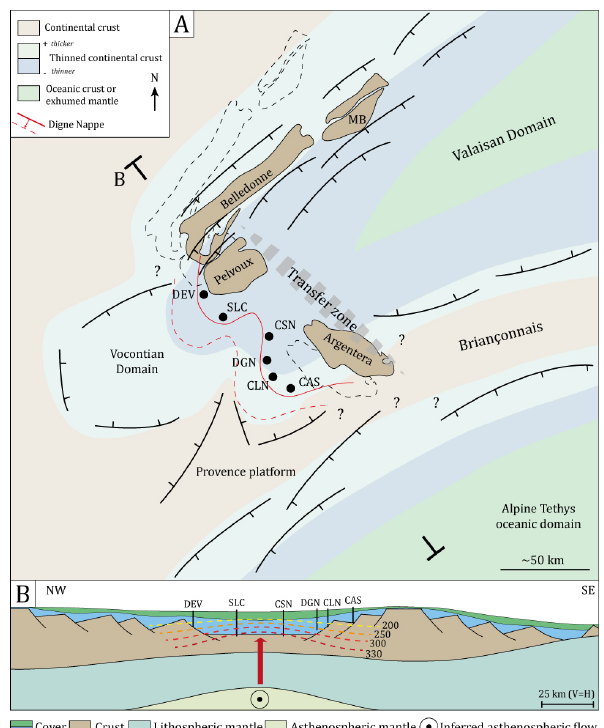
Figure 7. (a) Palaeogeographic reconstruction of the European mar- gin in the Western Alps, during the Early Cretaceous after Beltrando et al. (2012), Dumont et al. (2012), Angrand and Mouthereau (2021) and Lemoine et al. (1986). Restored positions of the External Crys- talline Massifs are after Bellahsen et al. (2014) and the Digne Nappe is restored based on shortening estimates from Ford et al. (2006). The SW Alps and the Digne Nappe were located in the continuation of the Valaisan Domain, as a result of the W-directed propagation of the Early Cretaceous rift system into the Vocontian Domain. Dashed lines represent the present-day positions of the External Crystalline Massifs and the Digne thrust front. MB: Mont Blanc massif. (b) Schematic reconstruction of the rifted margin through the study area, see location in (a) . Dashed lines are notional isotherms ( ◦